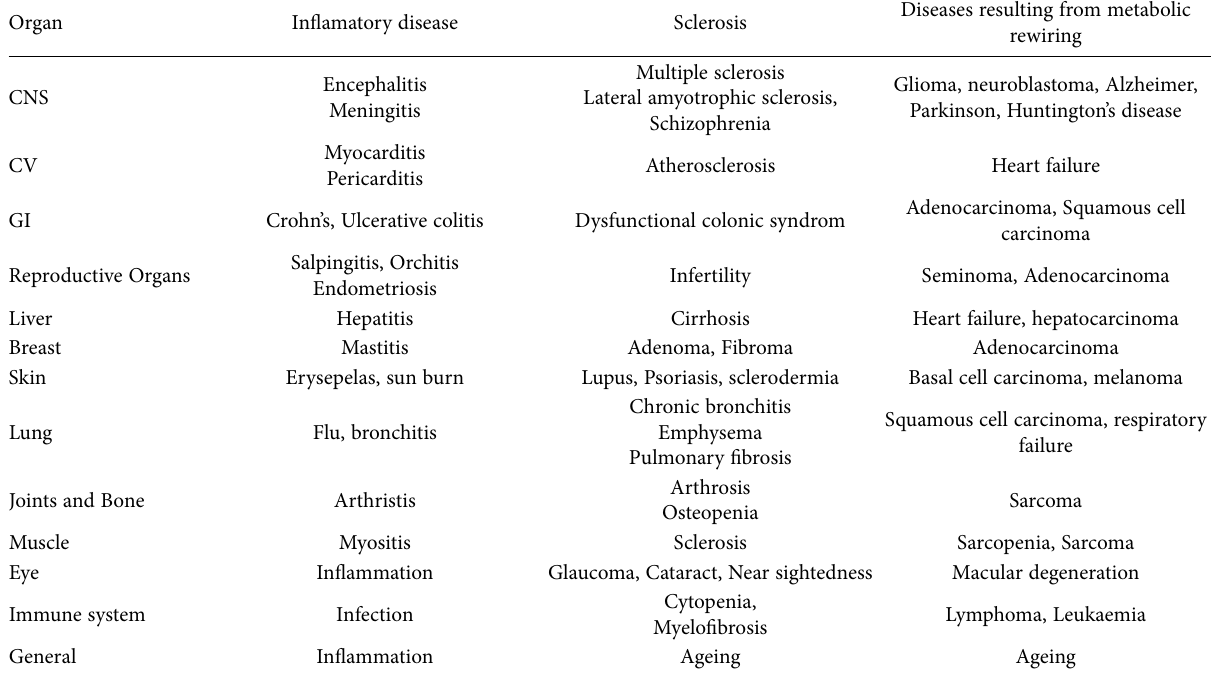
Table 2. classification of